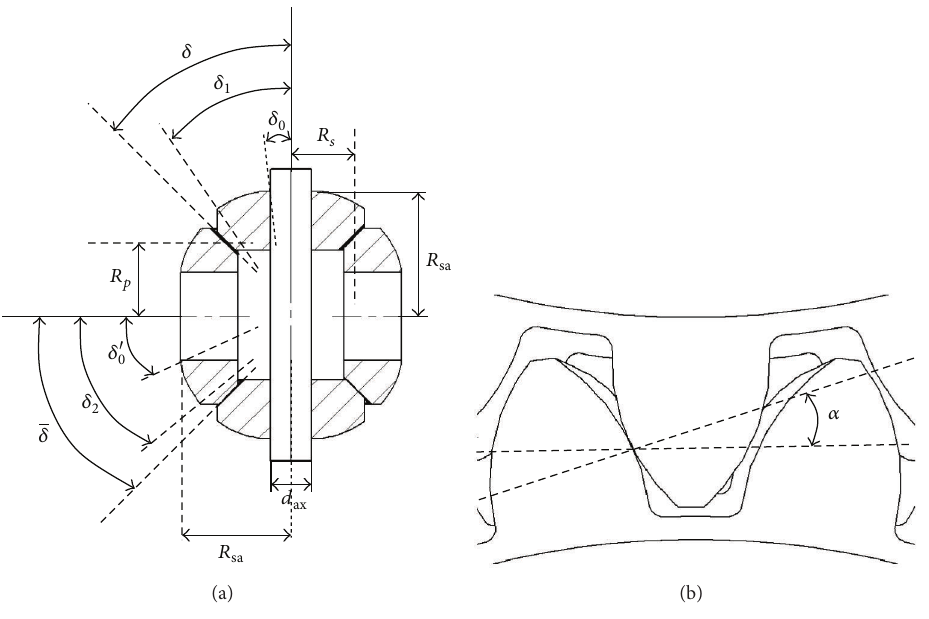
Figure 8: Geometry of a differential gearbox.